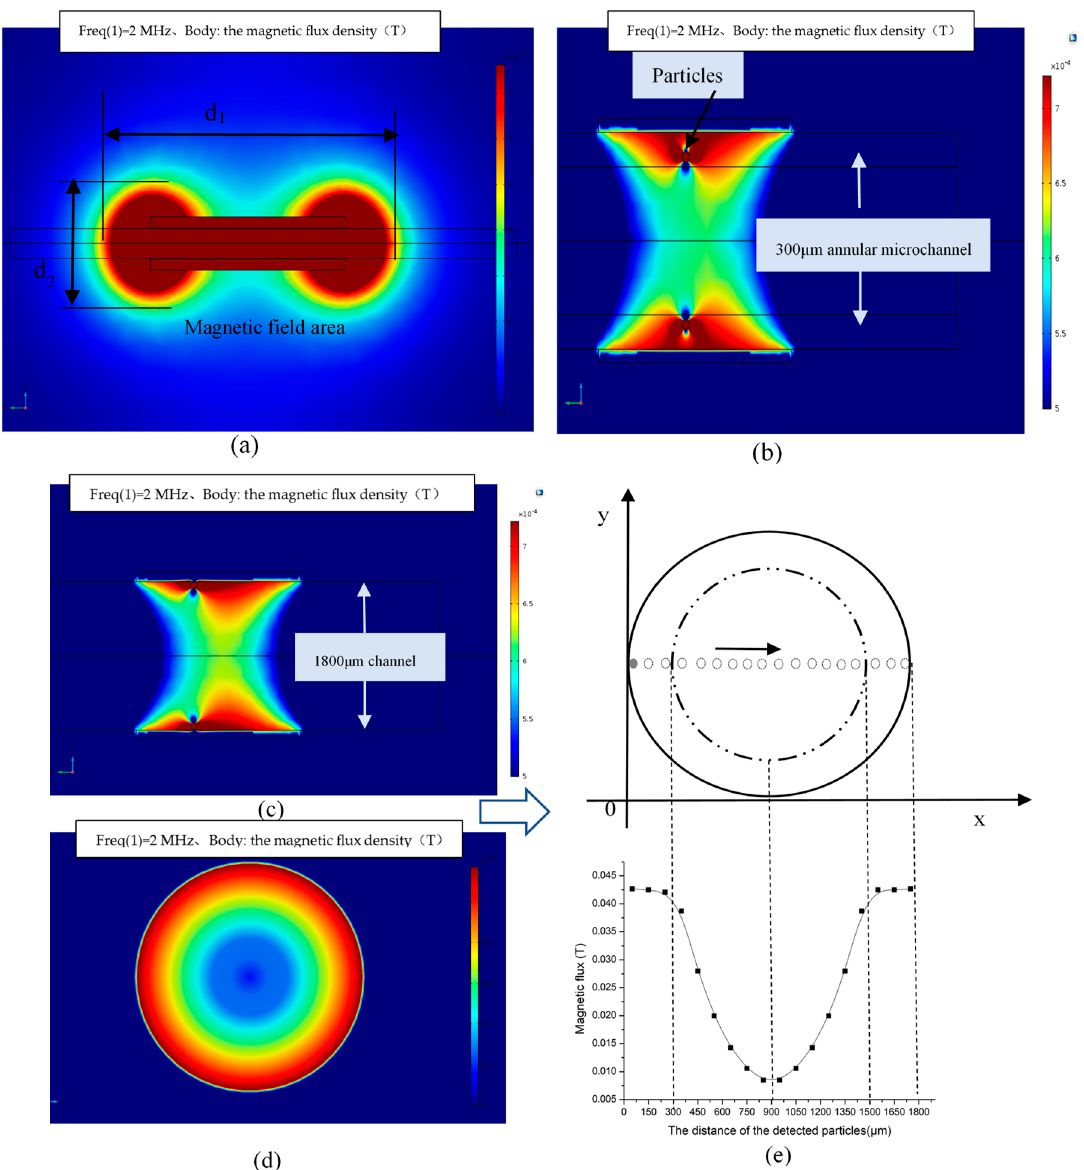
Figure 4. Analysis of COMSOL simulation results. ( a ) Cloud diagram of the magnetic field area of 300 µ m microchannel, d1, d2 are the length and width of the magnetic field area; ( b ) cloud image of the simulation e ff ect of iron particles in the 300 µ m annular microchannel; ( c ) cloud image of the simulation e ff ect of iron particles in the 1800 µ m channel; ( d ) the section of the magnetic field inside the 1800 µ m channel; ( e ) simulation results of the magnetic flux density of iron particles at di ff erent positions in the channel.